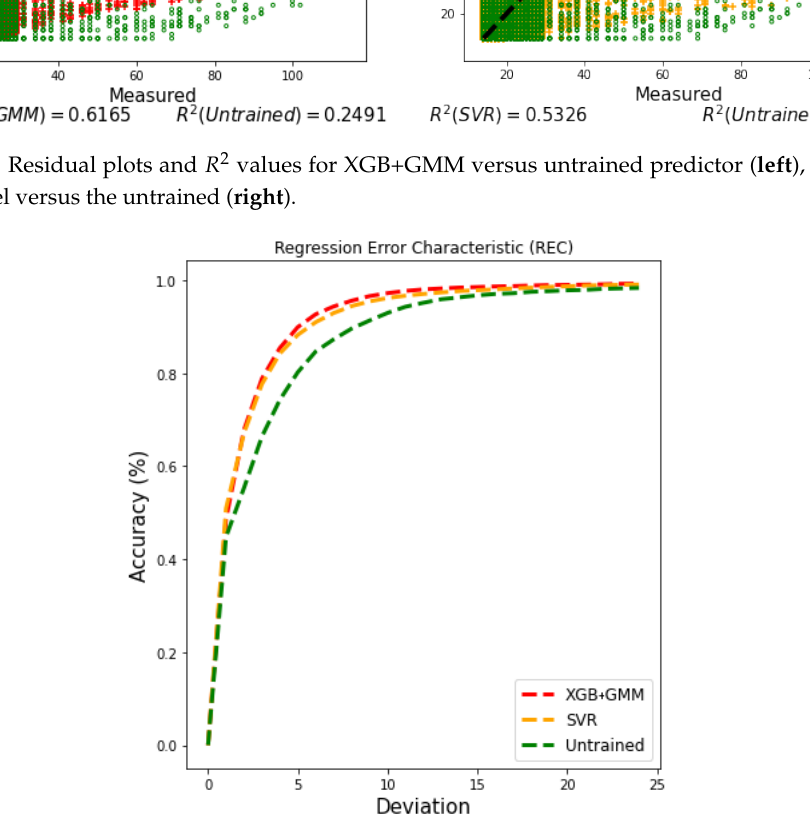
Figure 11. Regression error characteristic (REC) curves for the best XGB+GMM, and SVR models, together with the untrained